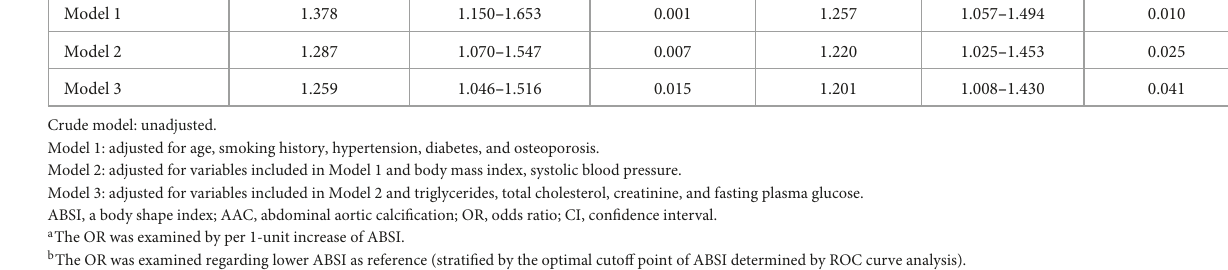
TABLE 2 Univariable and multivariable logistic regression analyses of associations between a body shape index (ABSI) and abdominal aortic calcification (AAC). ABSI as a continuous variable a ABSI as a categorical variable b OR 95% CI